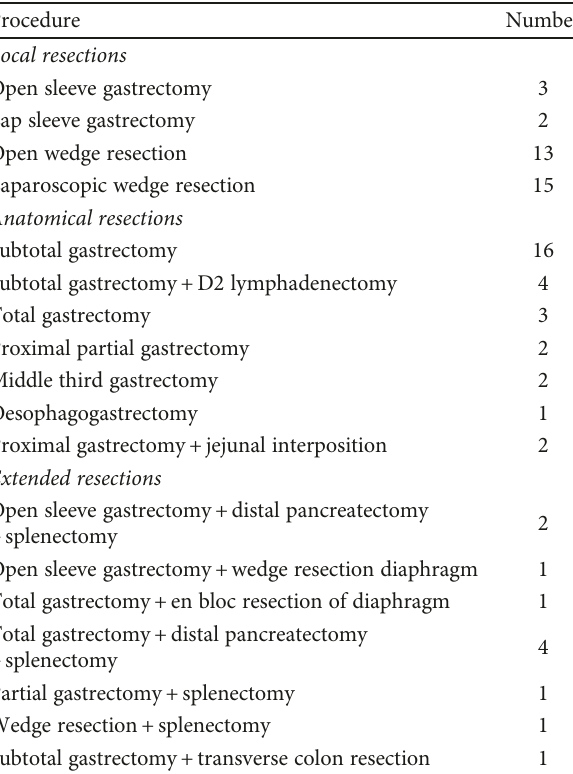
Table 1: Surgical